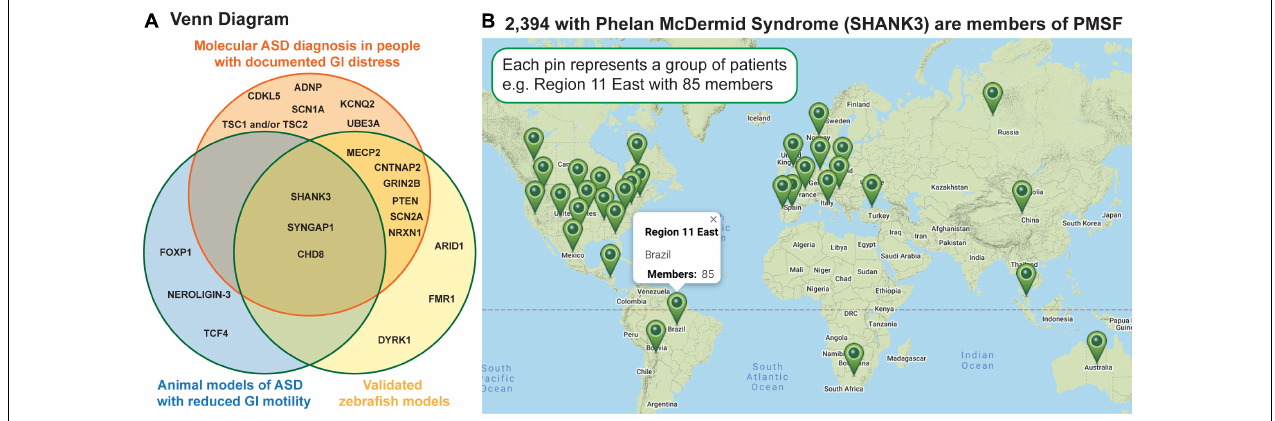
FIGURE 2 | Human genetics has identified 100s of sporadic, de novo genetic changes that can cause ASD; shown are a subset of these that report GI distress as a major symptom. (A) The Venn diagram shows genes linked to GI distress in ASD in the orange circle, those which have extant zebrafish models in the blue circle, and those in which reduced GI motility has been reported in an animal model. (B) The map shows where families caring for individuals with Phelan McDermid Syndrome are scattered across the globe making a standard of care challenging. This Google map image was generated by the Phelan McDermid Syndrome Foundation and is reproduced above with their